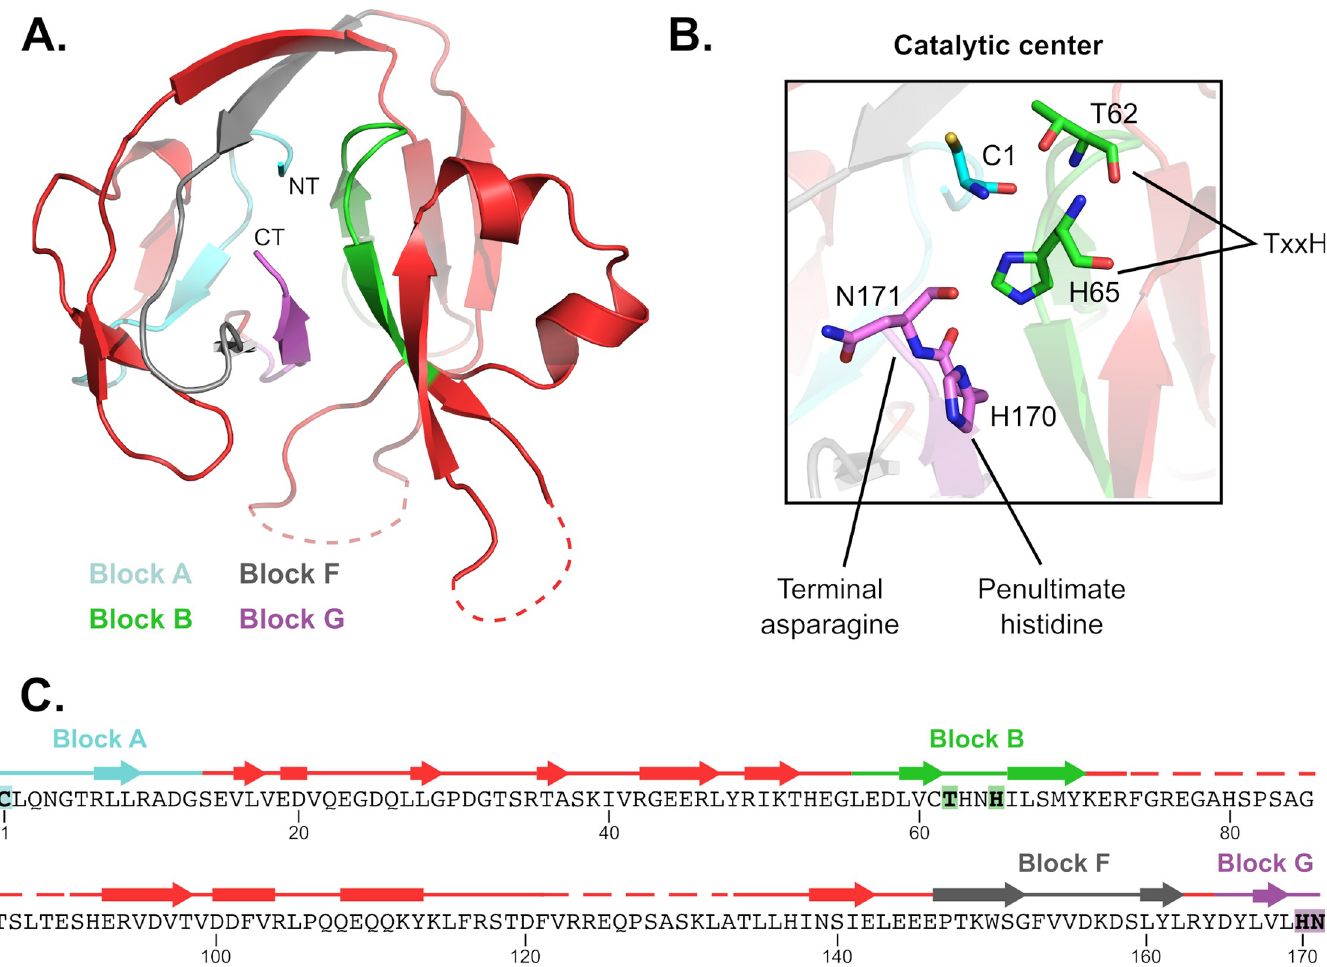
Fig 2. Structure and features of the Cne Prp8 intein. (A) A crystal structure of the Cne Prp8 intein from site a was solved to 1.75 Å resolution. This structure has the canonical horseshoe shape and resolution of the 4 splicing blocks, indicated in cyan (Block A), green (Block B), gray (Block F), and purple (Block G; Fig 1C). The NT and CT are annotated. Some regions of the structure are unresolved (dashed lines) and likely represent remnants of the original endonuclease domain or linker sequences. (B) Features of the active site. The catalytic center is shown, highlighting the first residue of the intein (C1), the penultimate histidine (H170), and the terminal asparagine (N171). The Block B TxxH motif is shown in green with T62 and H65 represented as sticks. These residues are critical to carrying out autocatalytic protein splicing. (C) Sequence of the Cne Prp8 intein (residues 1–171) overlaid with secondary structure features. Blocks distant in sequence fold close in 3D space to allow protein splicing to occur. Unresolved regions (dashed lines) are between Blocks B and F. Arrows represent β -strands, rectangles are α -helices. Residues noted in Fig 2B are highlighted. Cne , C . neoformans ; CT, carboxy terminus; NT, amino terminus; Prp8, pre-mRNA processing factor